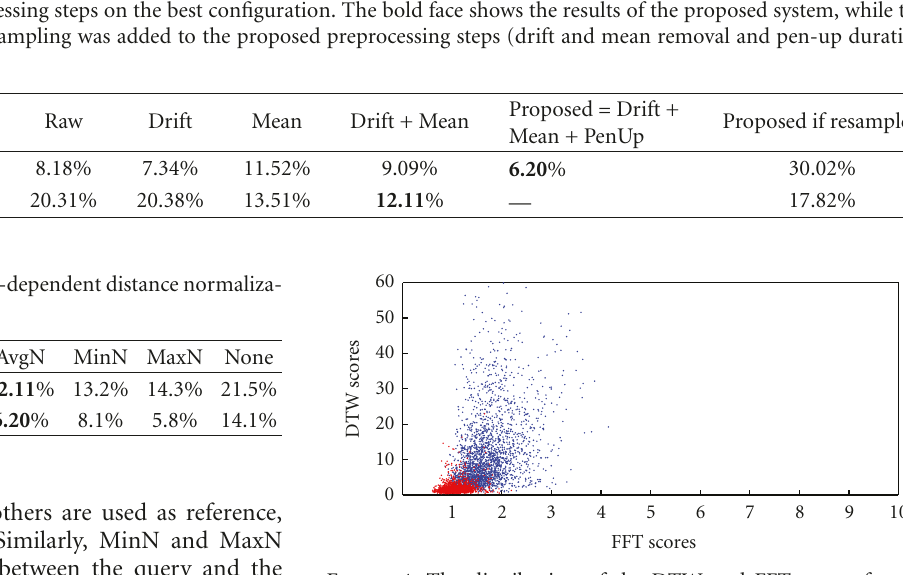
Figure 4: The distribution of the DTW and FFT scores for the MCYT-100